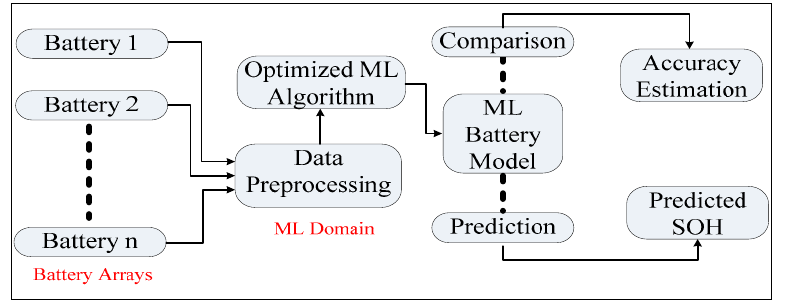
Figure 1. The ML battery modeling schematic